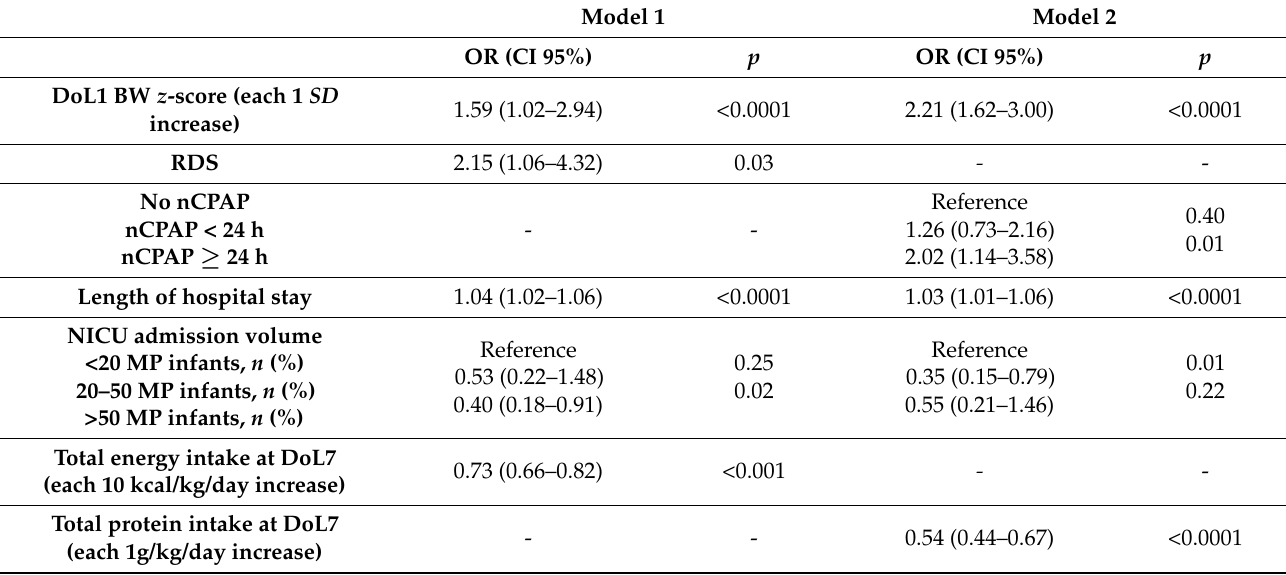
Table 4. Multivariable generalized logistic regression modeling EUGR with energy (Model 1) or protein (Model 2) intake at the end of first